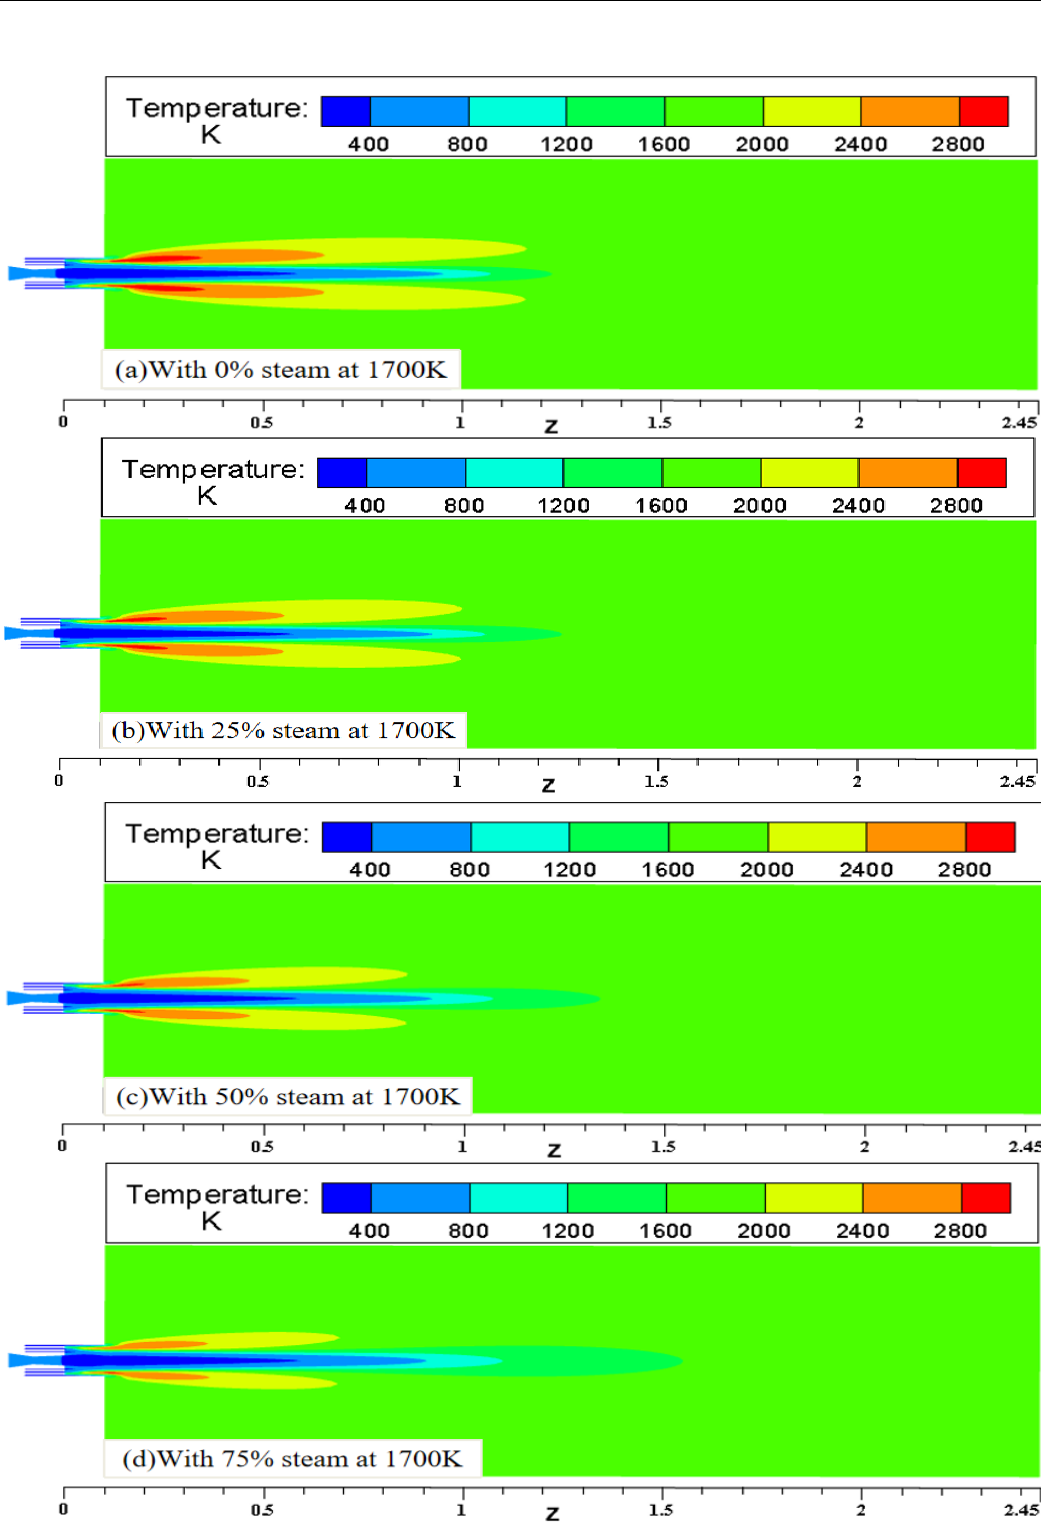
Figure 11. Total temperature distributions of the H 2 O and O 2 mixed jets in the longitudinal section at an ambient temperature of 1700 K under various conditions: ( a ) 0% steam and 100% oxygen; ( b ) 25% steam and 75% oxygen; ( c ) 50% steam and 50% oxygen; and ( d ) 75% steam and 25% oxygen.